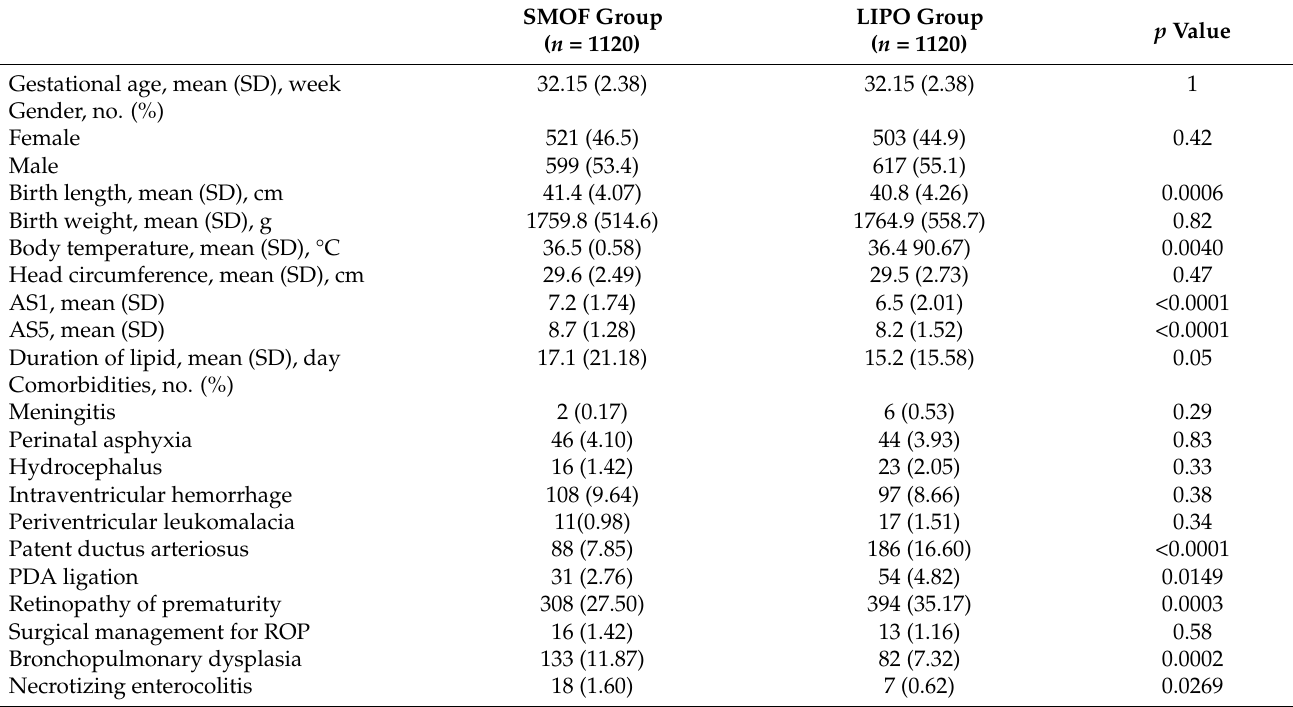
Table 2. The demographic and clinical characteristics of the SMOF and LIPO groups ( n = 2240).